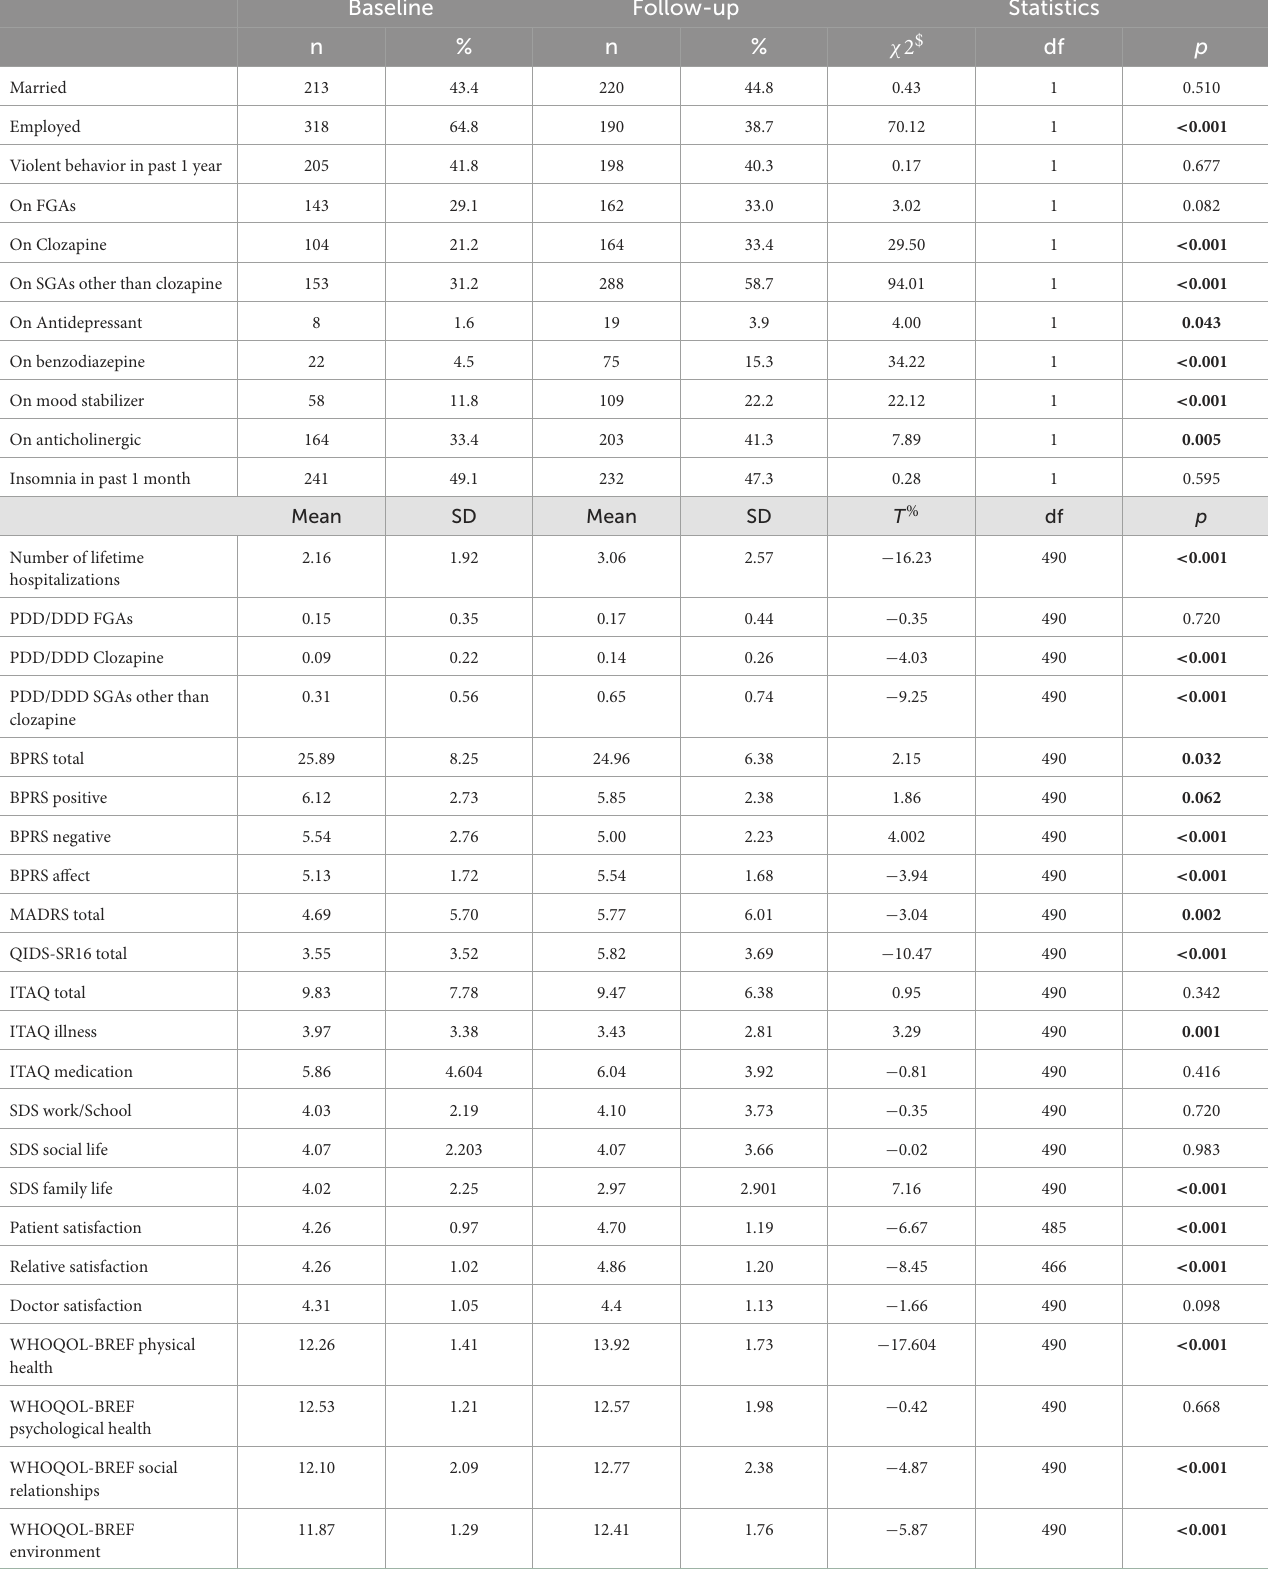
TABLE 2 Comparison of sociodemographic and clinical characteristics between baseline and 2-year follow-up in 491 patients with schizophrenia. Baseline Follow-up